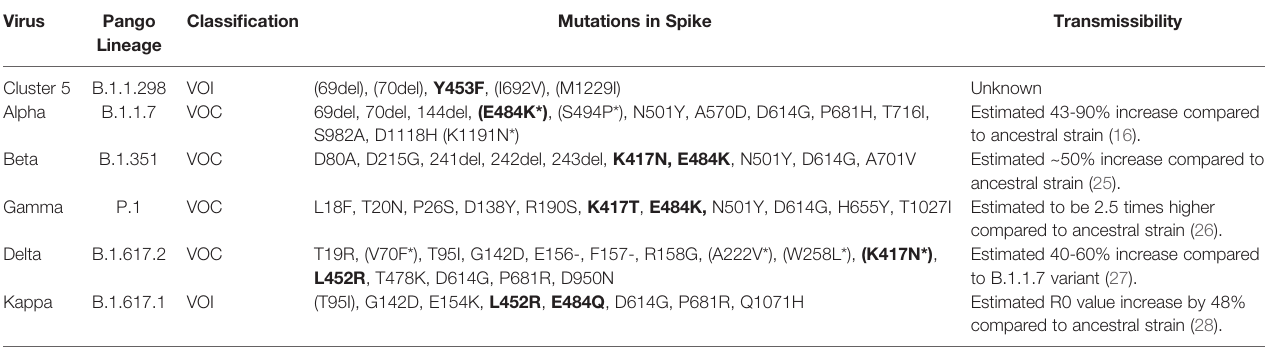
Table adapted from the Centre for Disease Control website. Mutations in brackets signify detection in some but not all viral sequences. Delta Plus is an informal name for the delta variant containing the K417N mutation. Plasmids used for this study bearing the speci fi c mutations are listed in the Supplementary File . Bold signify mutations implicated in immune escape. * denotes mutation present in some but not all sequences of this